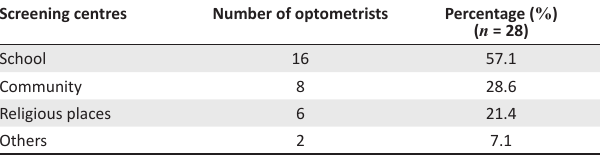
TABLE 2: Number of optometrists who performed vision screening in various screening centres. Screening centres